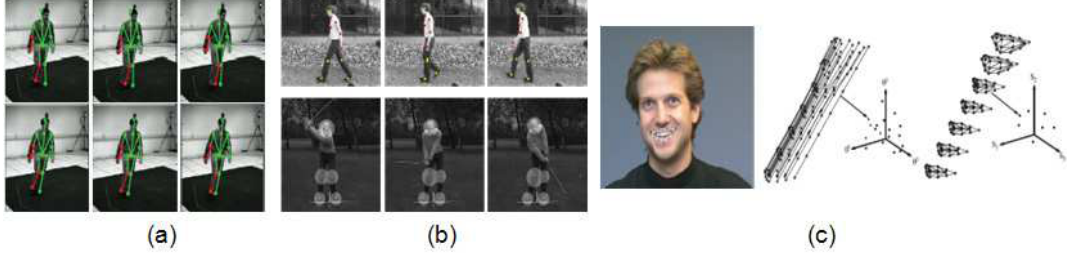
Figure 5. Examples of tracking sequences: ( a ) 3D tracking of the whole body, through a multiple hypothesis approach (frame extracted from [10]); ( b ) 2D tracking of body parts (frame extracted from [77]); ( c ) left: 3D features on a smiling mouth; right: a comparison of shape and trajectory space (frames extracted from